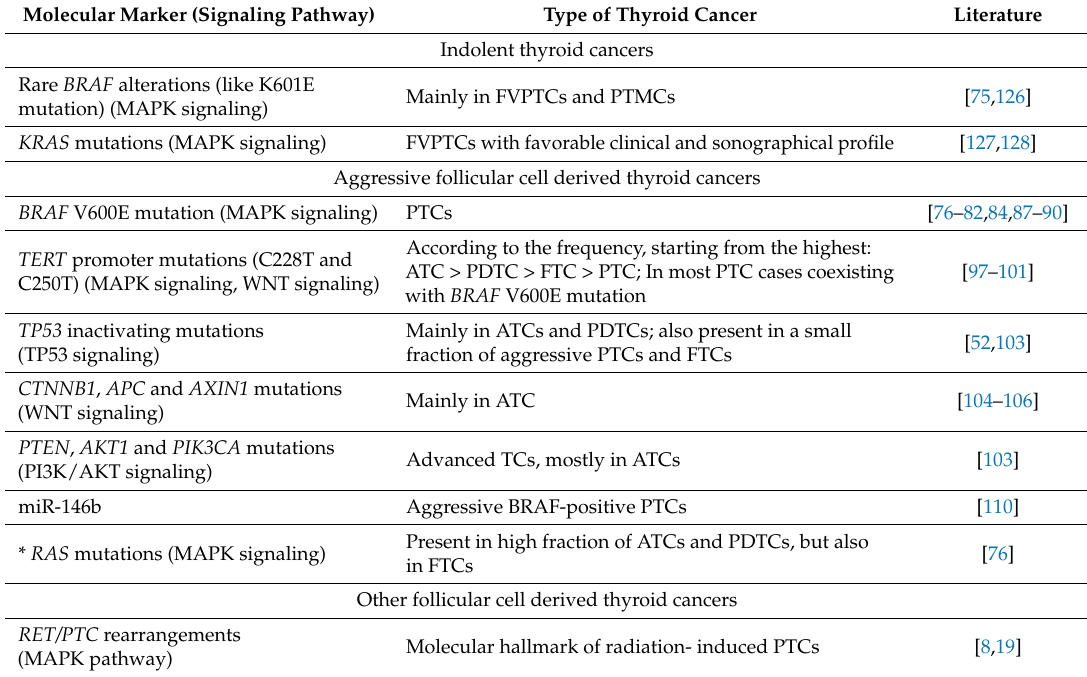
Table 3. Summary of the most important molecular markers of thyroid